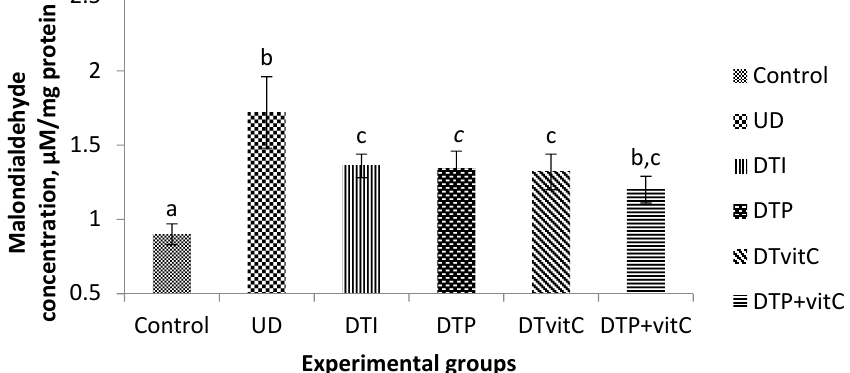
Figure 2. Effects of treatment with insulin, probiotic and vitamin C on brain, malondialdehyde concentrations of alloxan ‐ induced diabetic rats. Abbreviations: UD, untreated diabetic; DTI, diabetic + treated with insulin; DTP, diabetic + treated with probiotic; DTVit ‐ C, diabetic + treated with vitamin C; DTP + Vit ‐ C, diabetic + treated with probiotic and vitamin C. The values are expressed as mean ± S.E. ( n = 5). Values with different superscript letters are significantly ( p < 0.01) different.